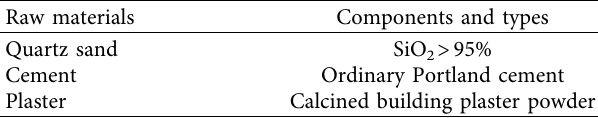
Table 1: Characteristics of raw component materials. Raw materials